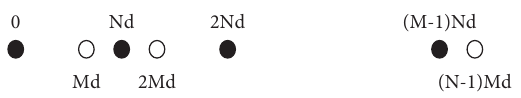
Figure 1: The structure of the coprime